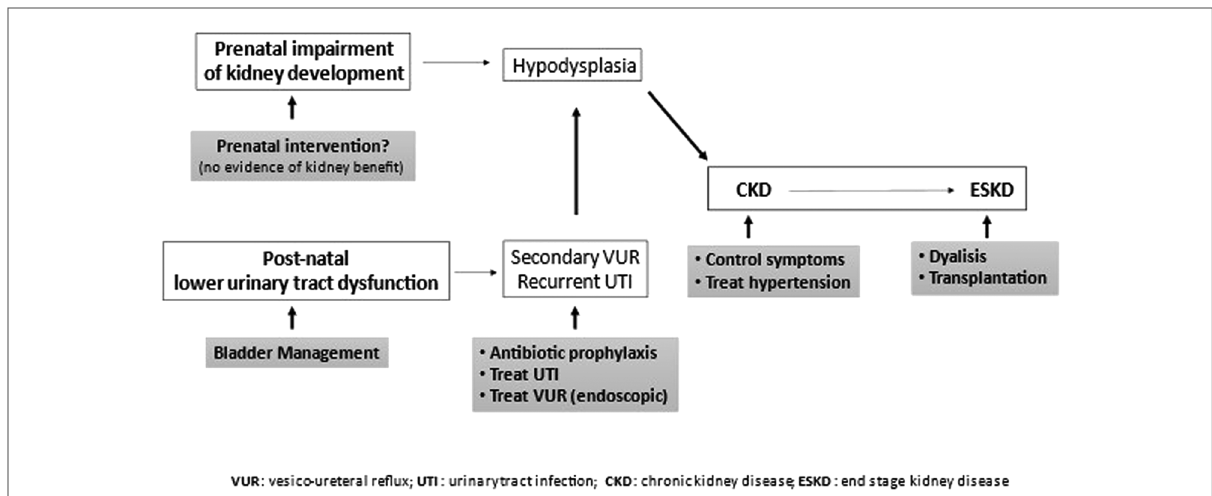
FIGURE 4 General principles of CKD and bladder dysfunction treatment. Prenatal intervention (vesicoamniotic shunting, valve ablation via fetal cystoscopy, vesicostomy by open fetal surgery) yields no renal bene fi t. Since lower urinary tract dysfunction increases risks of developing chronic kidney disease, it should be treated. Urinary tract infections should be prevented (prophylaxis) and treated. Symptomatic secondary vesico-ureteral re fl ux, which persisted despite management of lower urinary tract dysfunction, should be treated preferably with endoscopic technique. CKD progression should be slowed down, treating symptoms and hypertension, n end-stage kidney disease, dialysis or preferably transplantation is